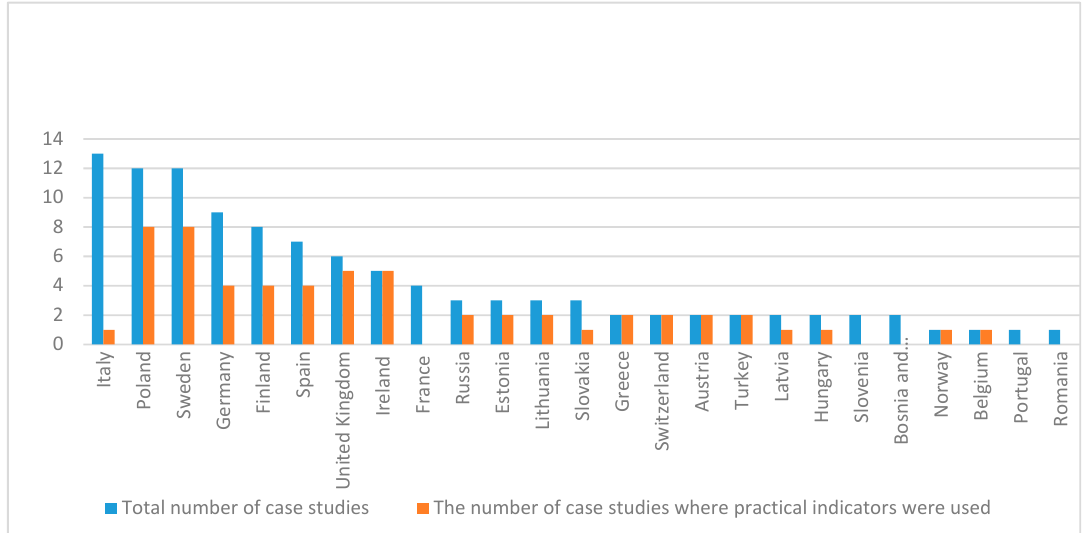
Figure 2. Distribution of case studies across biogeographic regions in Europe (note: nine studies had more than one case study area).